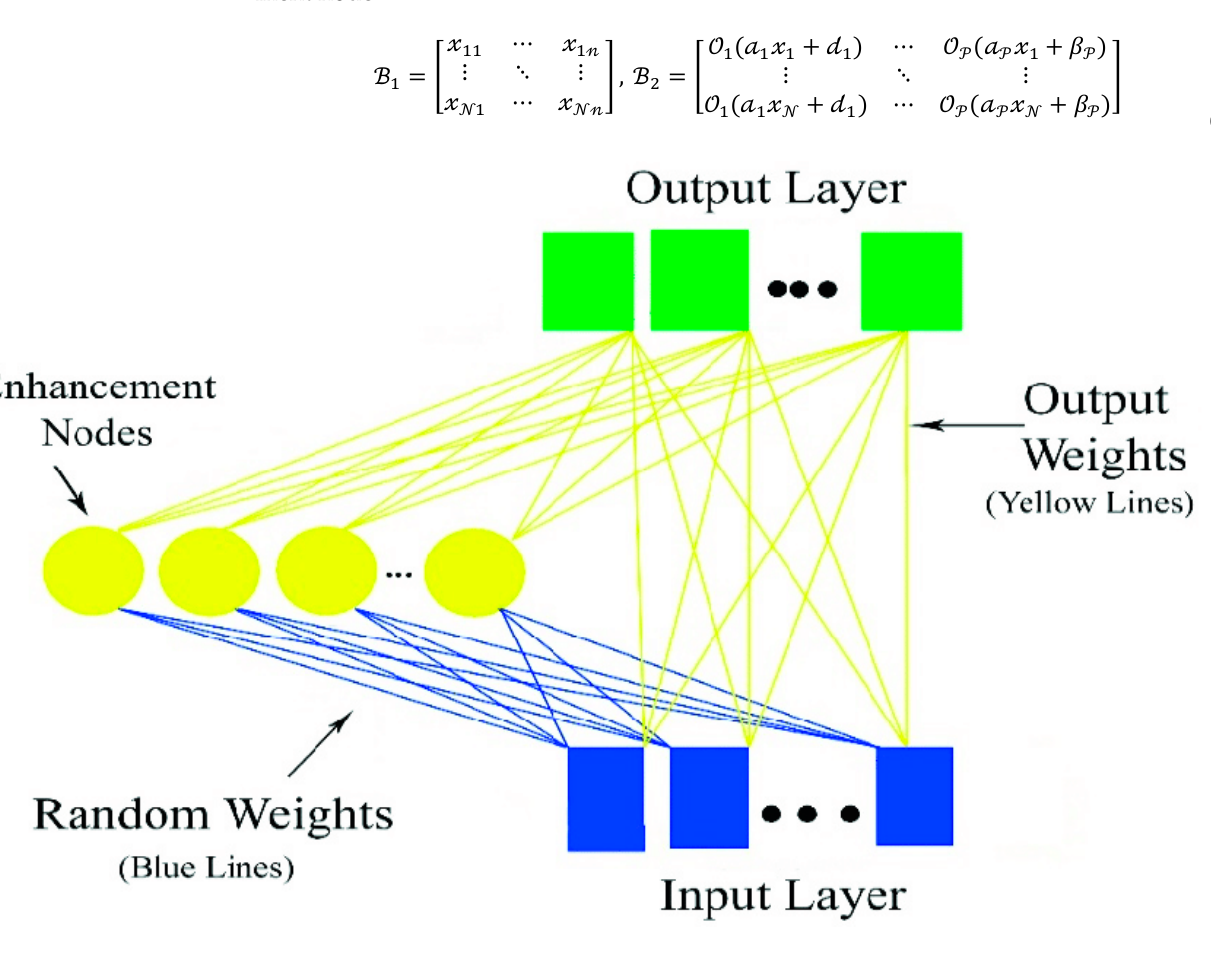
Figure 2. Schematic structure of RVFL. where † is the Moore‑Penrose